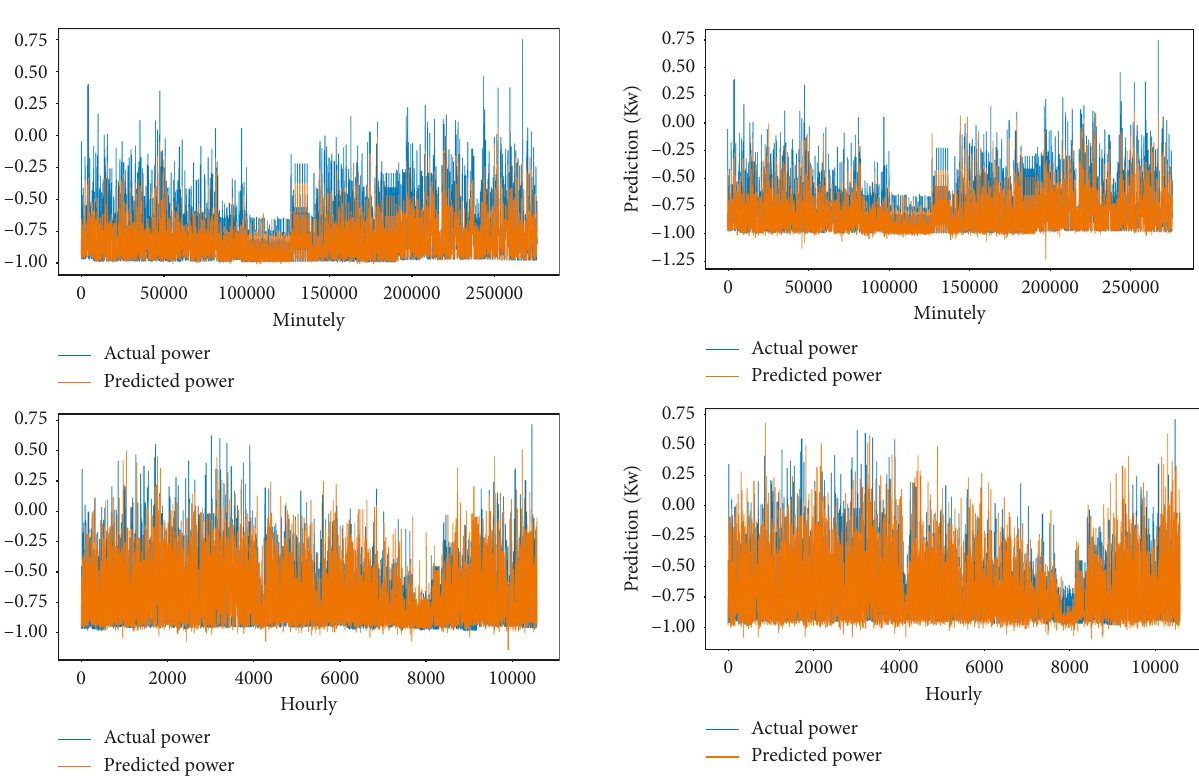
Figure 7: Visual representation of ED-GRU-based forecasting results considering minute and hour horizons on the household power dataset.